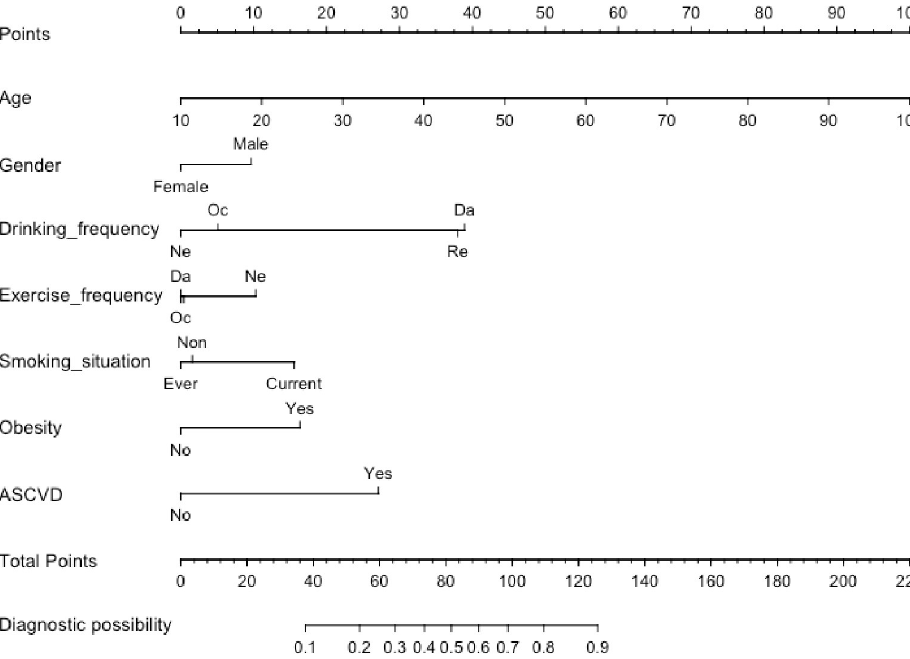
Fig 2. Nomogram to predict the presence of hypertension in T2DM patients. Abbreviations: ASCVD, atherosclerotic vascular disease. To use the nomogram, an individual participants value is located on each variable axis, and a line is drawn upward to determine the number of points received for each variable value. The sum of these numbers is located on the Total Points axis to determine the risk of hypertension.